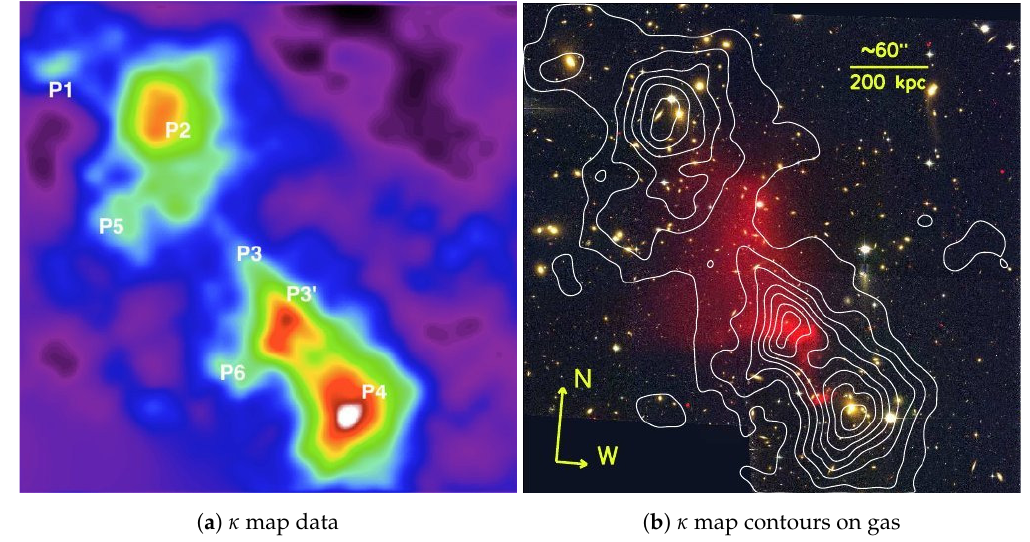
Figure 2. Abell 520 (Train Wreck Cluster) κ -map. One peak (P3 (cid:48) ) coincides with the gas